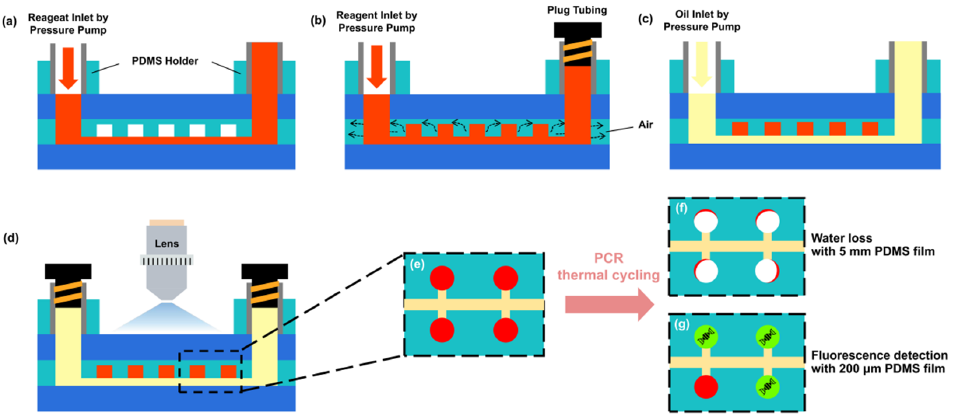
Figure 3. Operation procedure of the cdPCR G-P-G MFD: ( a ) filling the main channels with reagent using a pressure pump. ( b ) Plugging the outlet with a plugged tube and filling the chamber with the reagent. ( c ) Unplugging the tube in the outlet and injecting fluorinated oil to move out the reagent in the main channels to partite the water-phase reagent in the chambers. ( d ) After removing the injection tube, plugging inlet, and outlet. ( e ) Top view schematic of microchambers in cdPCR G-P-G MFD. ( f ) Serious water volume loss in the G-P-G MFD with a 5 mm-thick PDMS film after PCR thermal cycling. ( g ) Pretty low water volume loss in the G-P-G MFD with a 200 μ m-thick PDMS film after PCR thermal cycling. The red color is the reagent, the yellow one is oil. The Aquamarine color is PDMS chip, and the blue one is glass cover. The white color is air after reagent evaporation, and the green one is fluorescence.